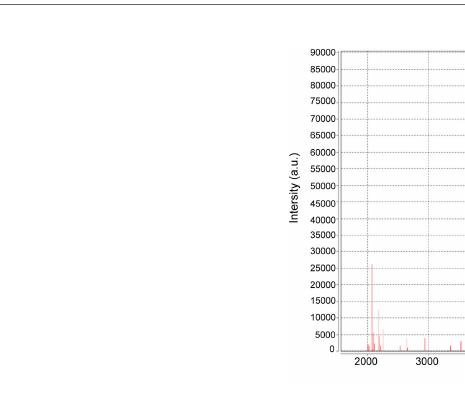
FIGURE 3 | The spectrum of strain SAHP1 via the VITEK MS MALDI – TOF MS.